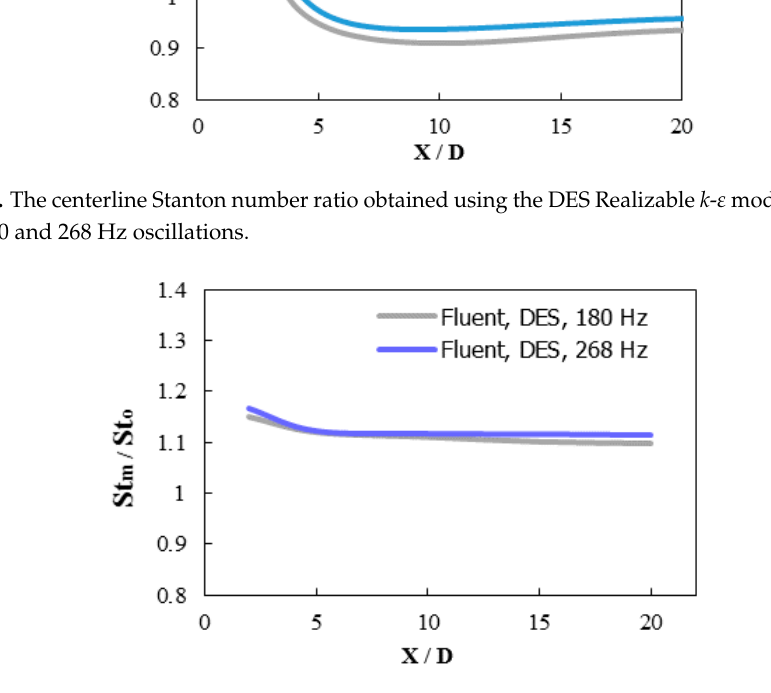
Figure 23. The spanwise-averaged Stanton number ratio obtained using the DES Realizable k - ε model for M = 0.5 for the 180 and 268 Hz oscillations.